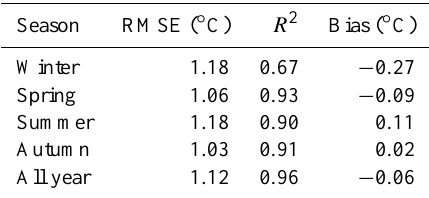
Table 7. Performance of the standard regression model in terms of RMSE, R 2 and bias computed over the validation set 4 in each sea- son. The stream network used to evaluate the model corresponds to the original one derived from the map at scale